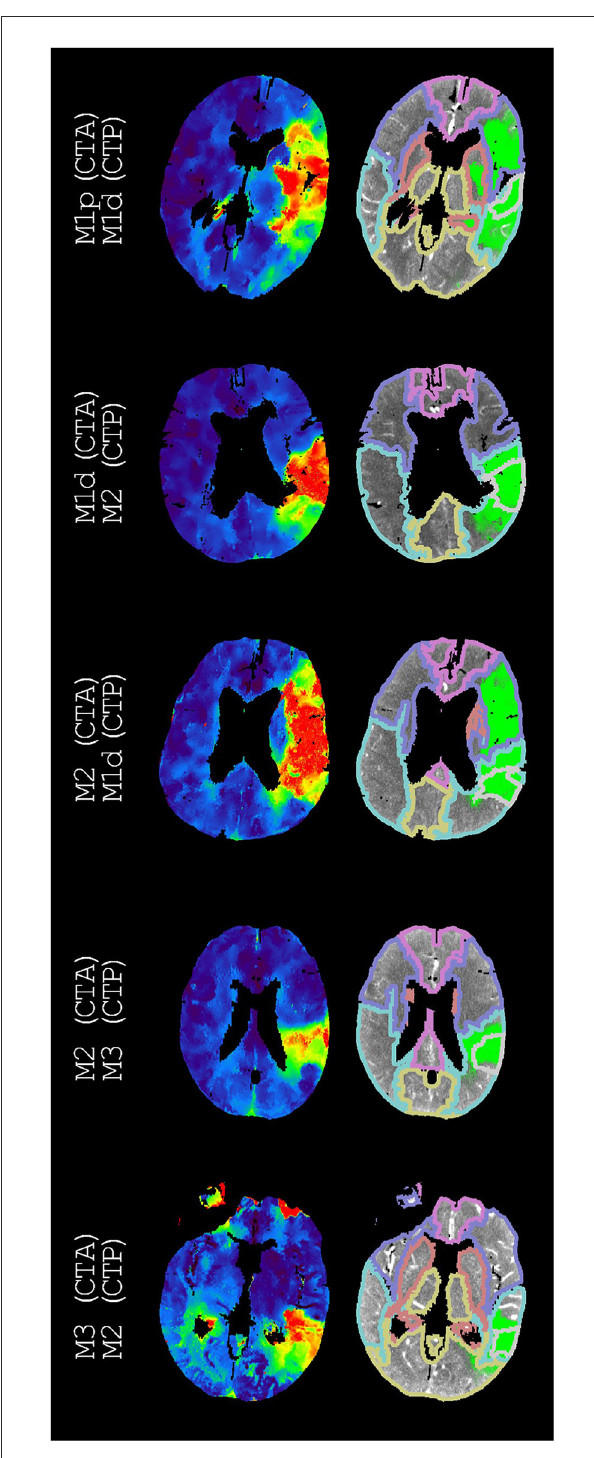
FIGURE4 Examples of annotations (CTA) and indications (CTP) that do not match different segments of the middle cerebral artery. On the left, time-to-peak perfusion maps are shown. On the right, the hypoperfused regions and the downstream regions (according to Figure 1) are shown. For each example, we only regarded the M3 downstream region with the highest intersection-over-union. These M3 downstream regions are the superior temporal region, the supramarginal region, the supramarginal region, the supramarginal region, and the middle temporal region (from top to bottom). The second best indications were M1p, M1d, M1p, M2, and M1d (from top to bottom).